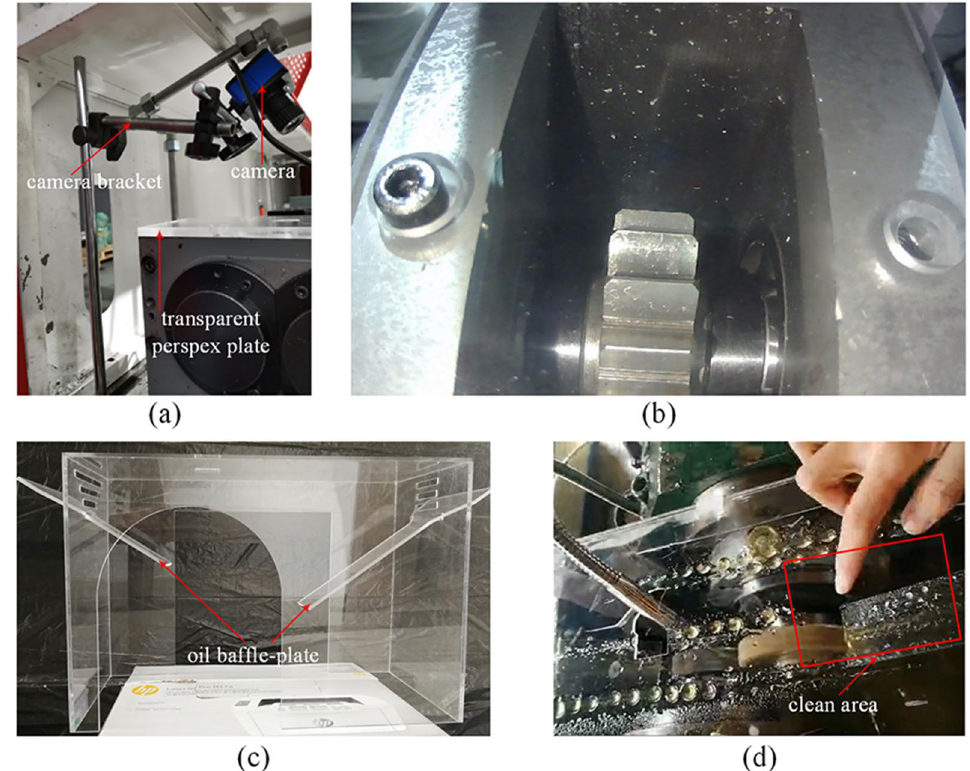
Figure 7 Visual detection platform for gear pitting: a visual detection device, b image acquisition, c case with oil baffle-plate, d effect of oil